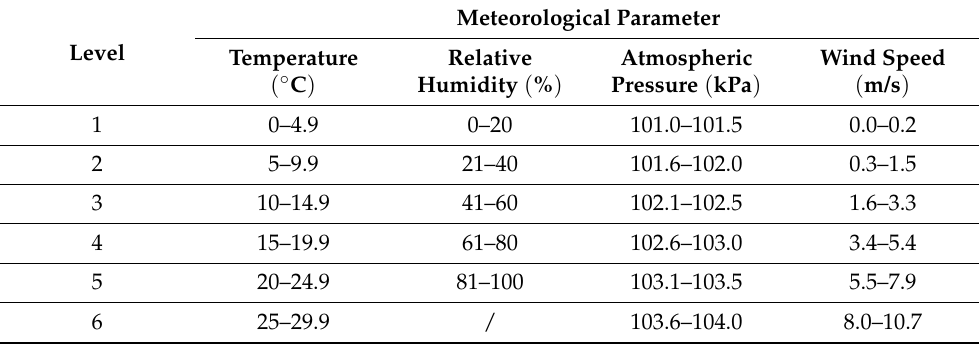
Table 8. Classification of meteorological